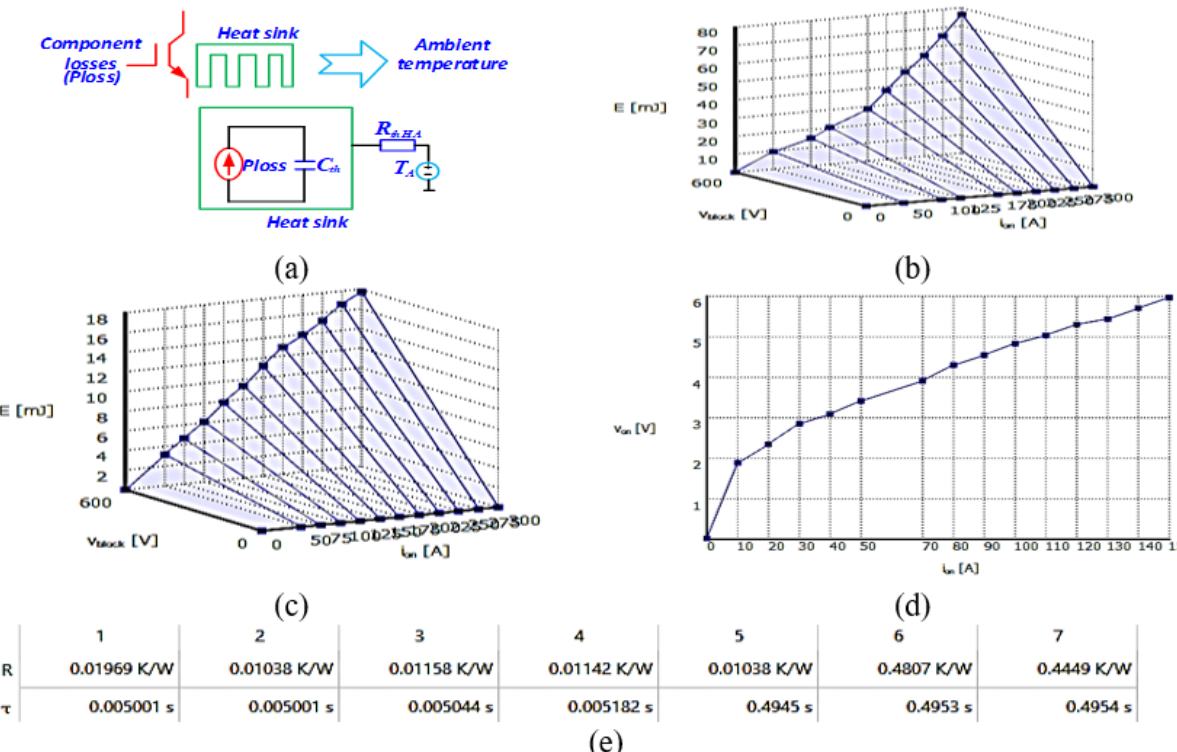
Fig. 7. (a) Electrical thermal model; Silicon made SEMIKRON Switches S 7 -S 8 (b) Turn-on loss (c) Turn-off loss (d) Output characteristics-Conduction loss (e) Thermal impedance characteristics